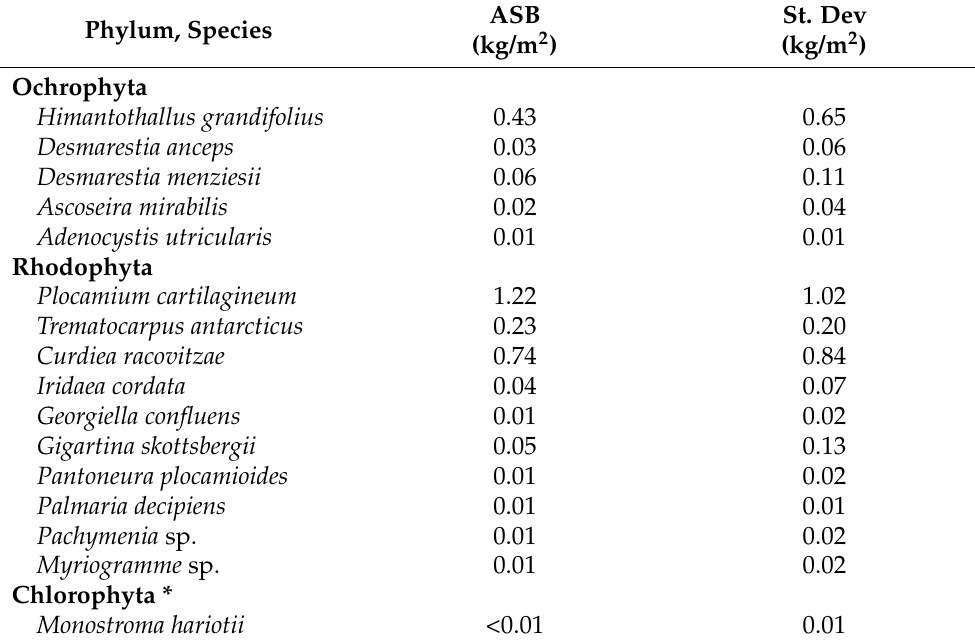
Table 3. Sixteen algal species were identified in this study, and their mean area-specific biomass (ASB; kg/m 2 ) among 11 ice pits (two quadrats per ice